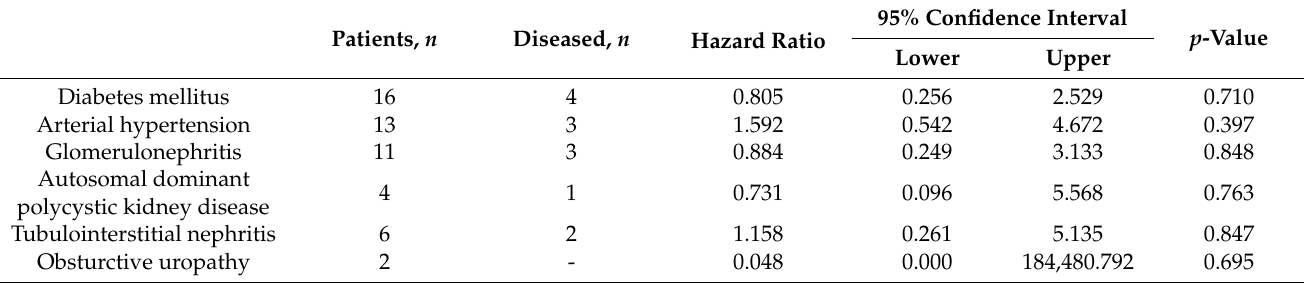
Table 4. Results of univariate Cox regression analysis after sorting patients based on their primary disease in correlation with data obtained from lectin microarray with GNL between survivors ( n = 39) and non-survivors ( n = 13).